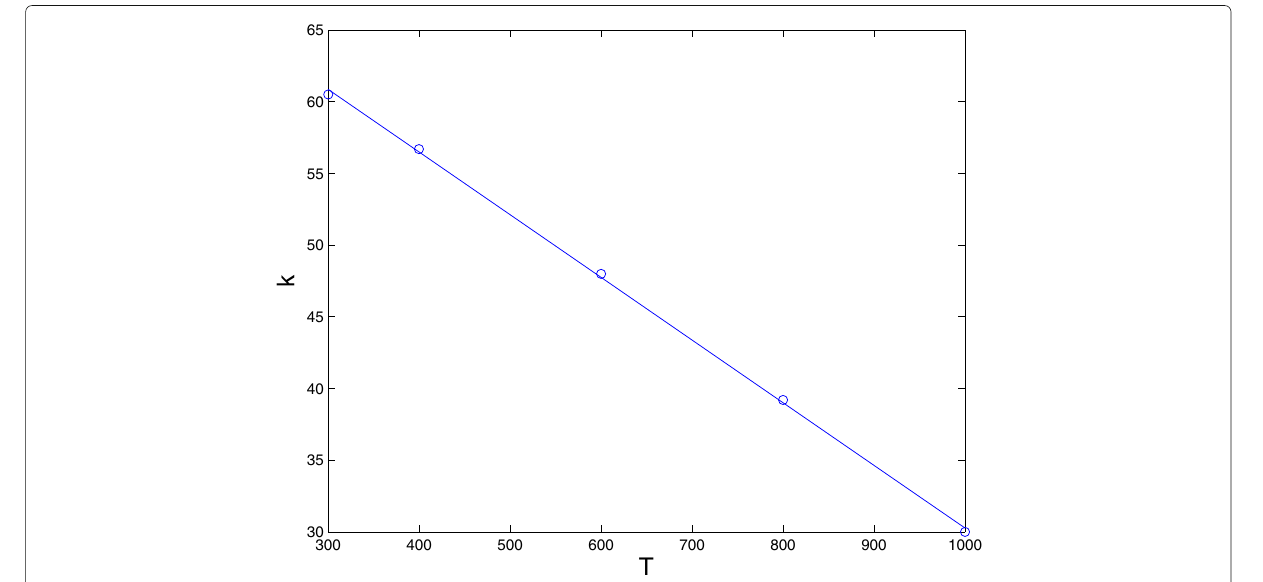
Fig. 3 Variation of the heat conductivity k (W/m.K) for steel with absolute temperature T in Kelvin